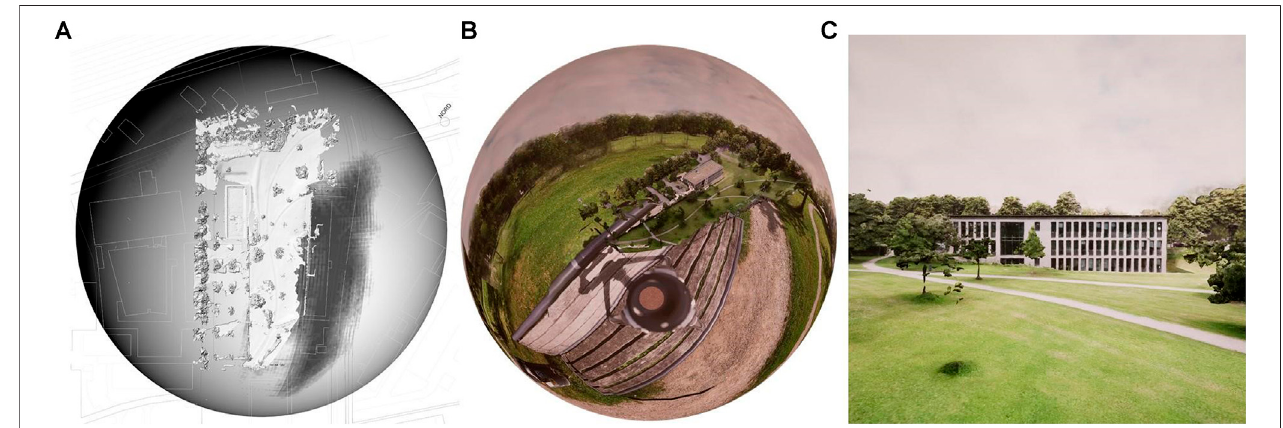
FIGURE 4 | Visual de fi nitions for (A) geometry, (B) materials, and (C) fi nal view from the receiver position of Demonstrator A.